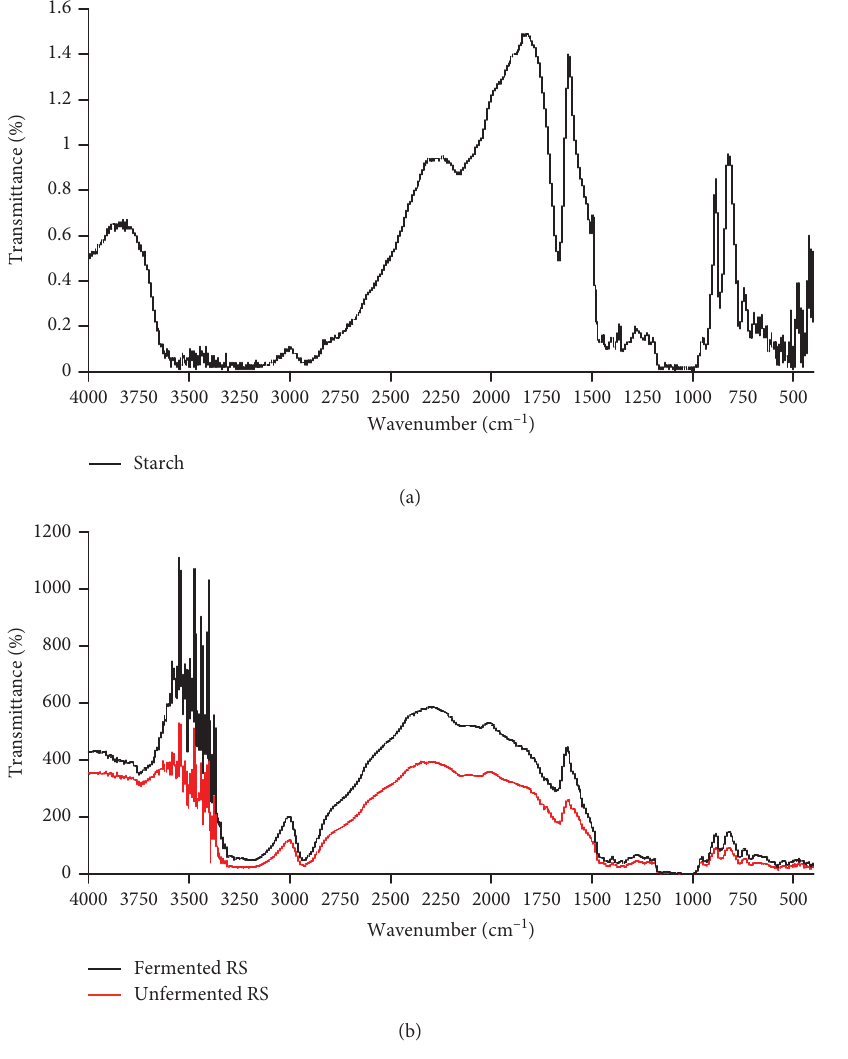
Figure 2: FTIR map of sorghum and resistant starch. Table 4: Distribution of branched chain length in sorghum and resistant